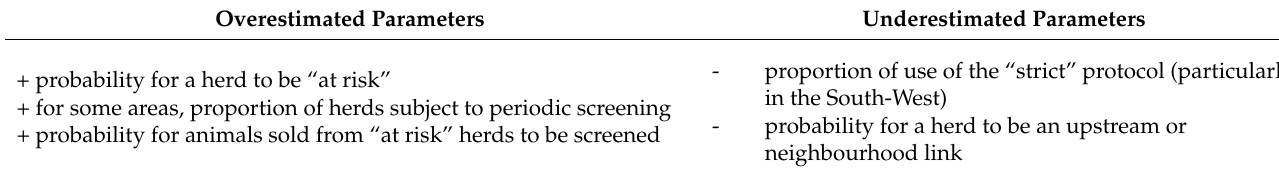
Table 2. Summary of over- and underestimated